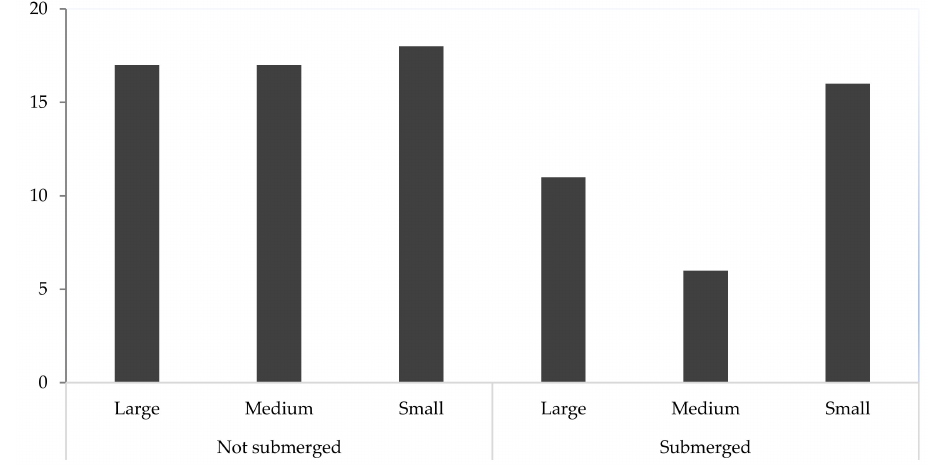
Figure 3. Reintroduction plan showing samples (2–3 seedlings/sample) of different size seedlings (small, medium, and large) of Dactylorhiza incarnata subsp. ochroleuca planted in the wild site. Seedlings were either submerged or not submerged at the time of